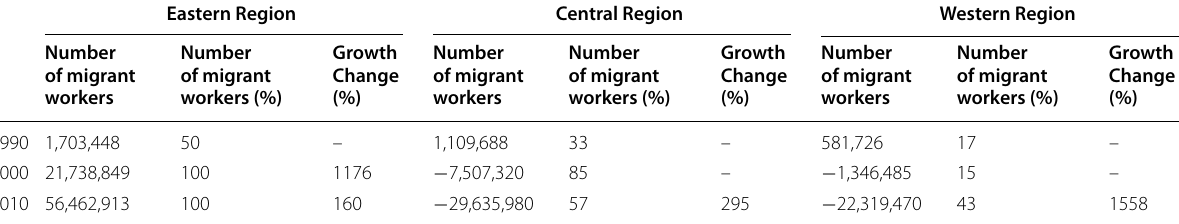
Table 3 Net migration flows in three regions in 1990, 2000, and